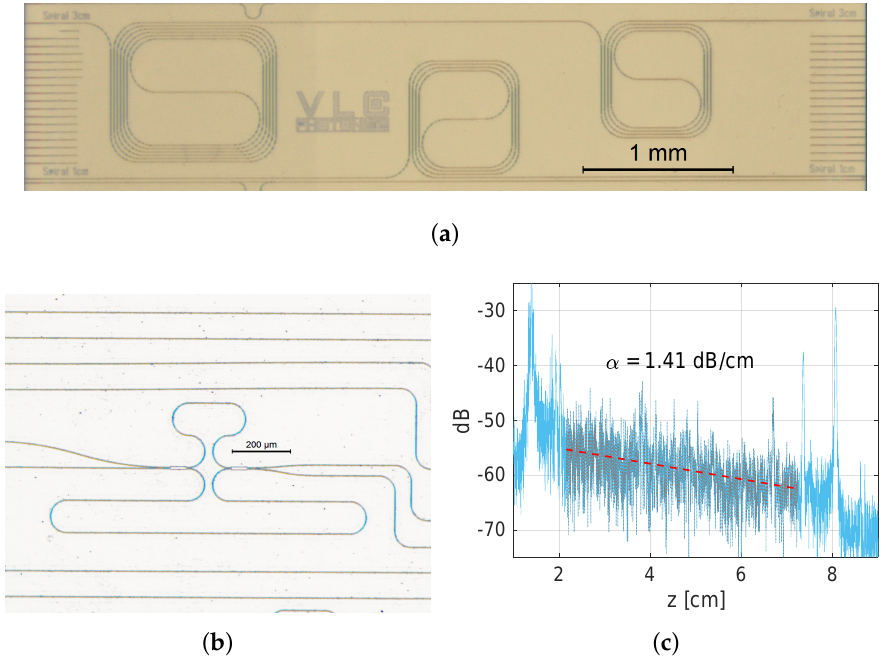
Figure 5. Test structures devised for the characterization of the propagation loss, ( a ) spiral waveguides and ( b ) Mach-Zehnder Interferometers and ( c ) optical frequency domain reflectometry trace from a spiral waveguide, the light blue trace is the measurement, the gray shaded part corresponds to the range selected for a linear fit, which is shown in the figure as dashed red